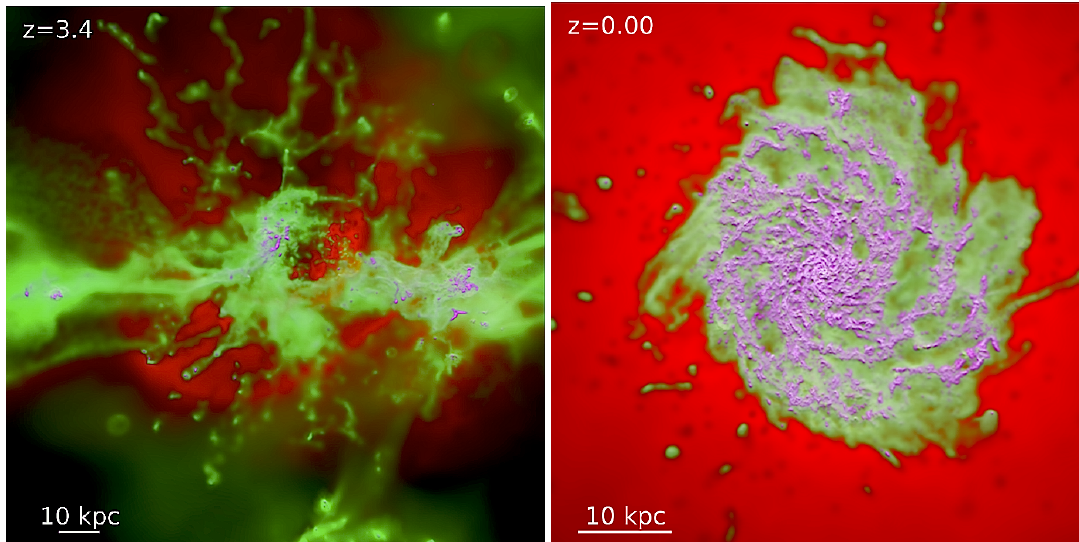
Figure 6. Figure from Hopkins et al. [60]. The figure shows the projected gas density (log-weighted) in a simulation of a Milky-Way-like halo. Magenta corresponds to cold molecular/atomic gas ( T < 1000K), green to warm ionized gas (10 4 (cid:46) T (cid:46) 10 5 K), and red shows hot gas ( T (cid:38) 10 6 K). The two panels correspond to boxes centered on the main galaxy at z = 3.4 (on the left, the box is 200kpc physical on a side) and at z = 0 (on the right, the box is ∼ 50kpc on a